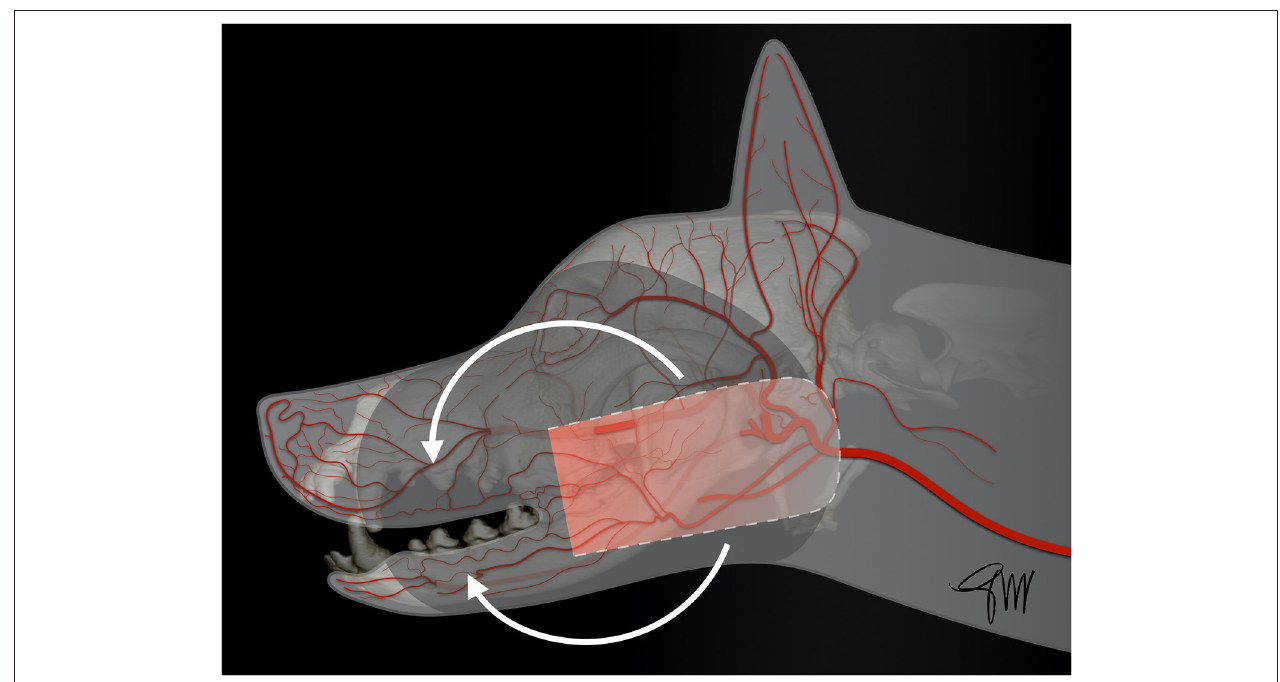
FIGURE 12 | Drawing depicting the surgical limits and extent of rotation of a facial (angularis oris) transposition